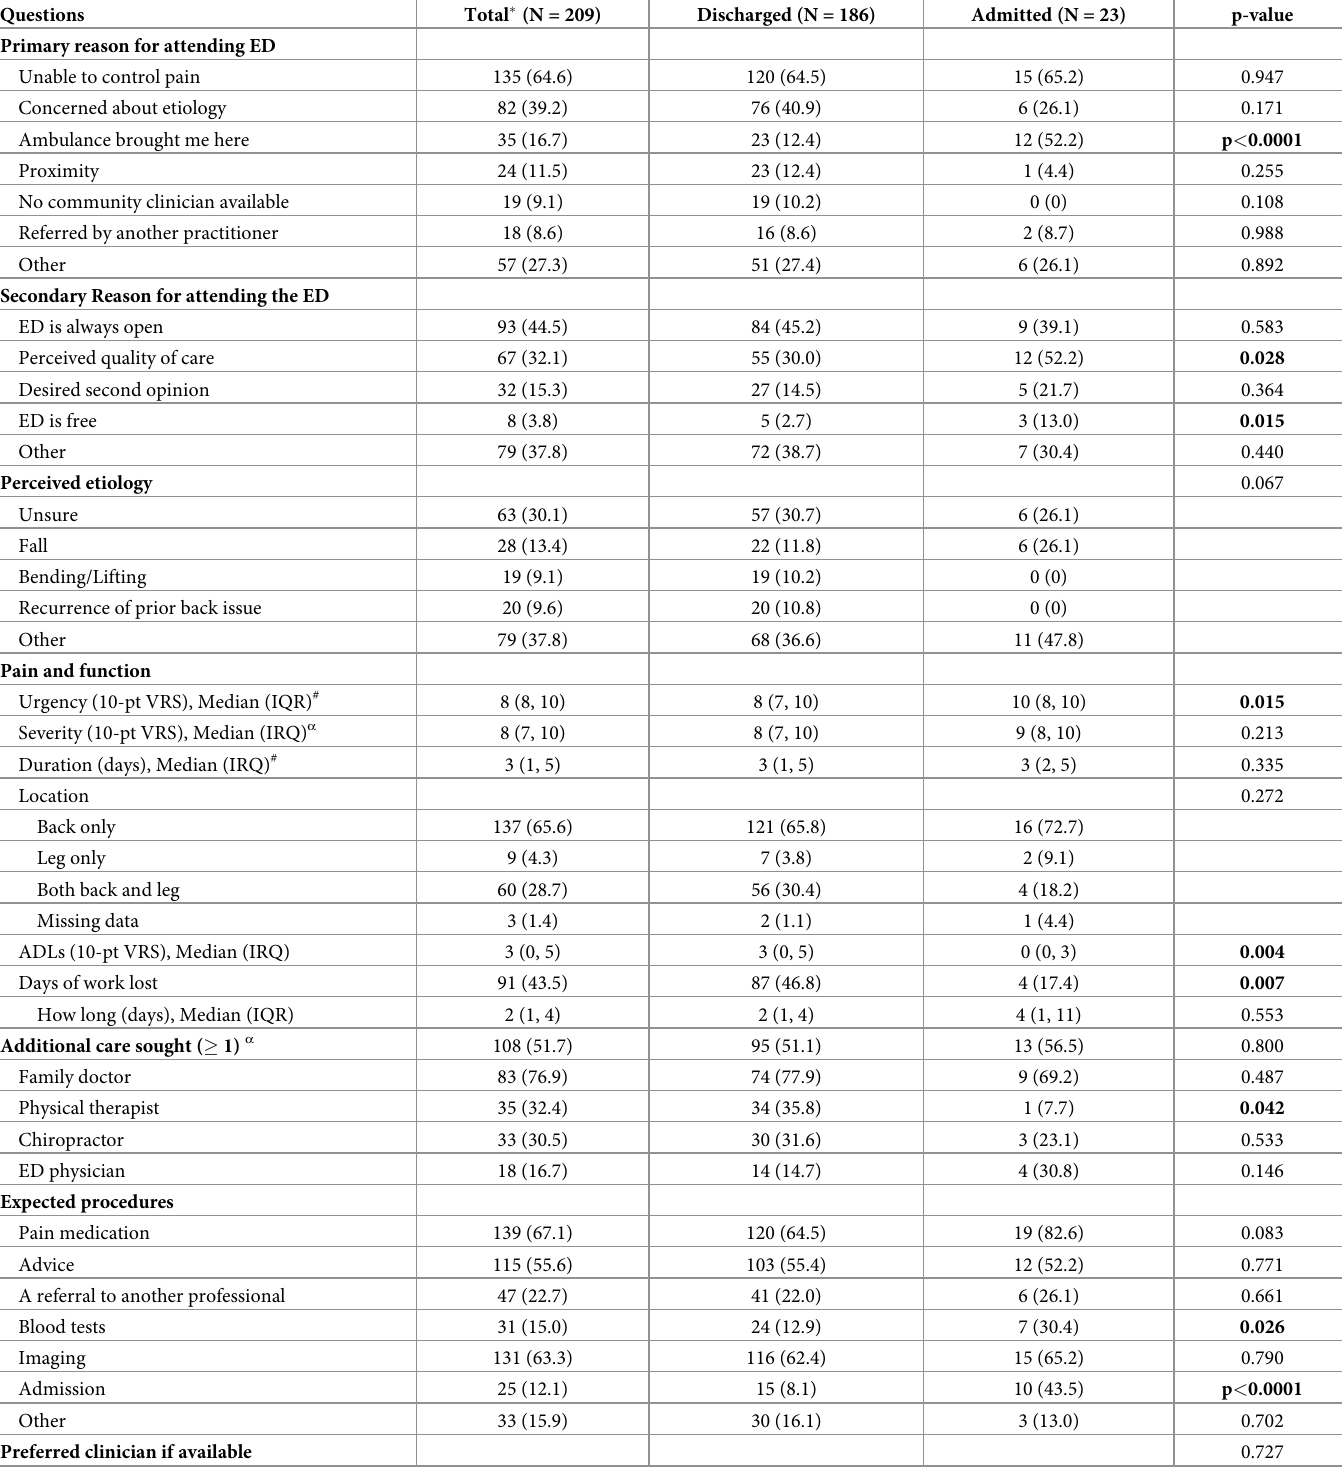
Table 2. Responses to a 13-item questionnaire by patients with acuity low back pain presenting to Canadian emergency department, sub-grouped by disposition